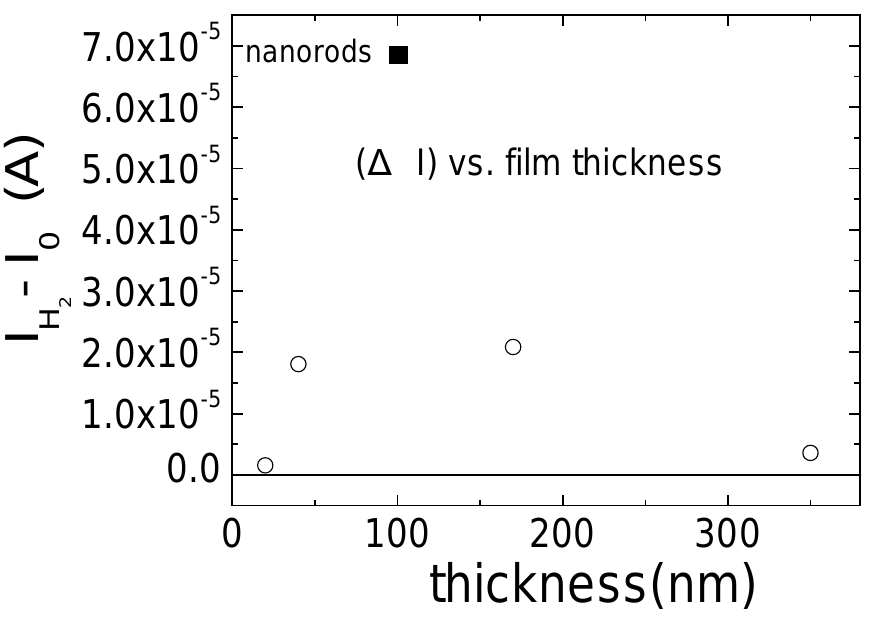
Figure 20. Change in current at fixed bias (0.5V) when switching to the H either Pt-coated ZnO nanorods or thin films as the gas ambient is switched from N N , then to air for 2